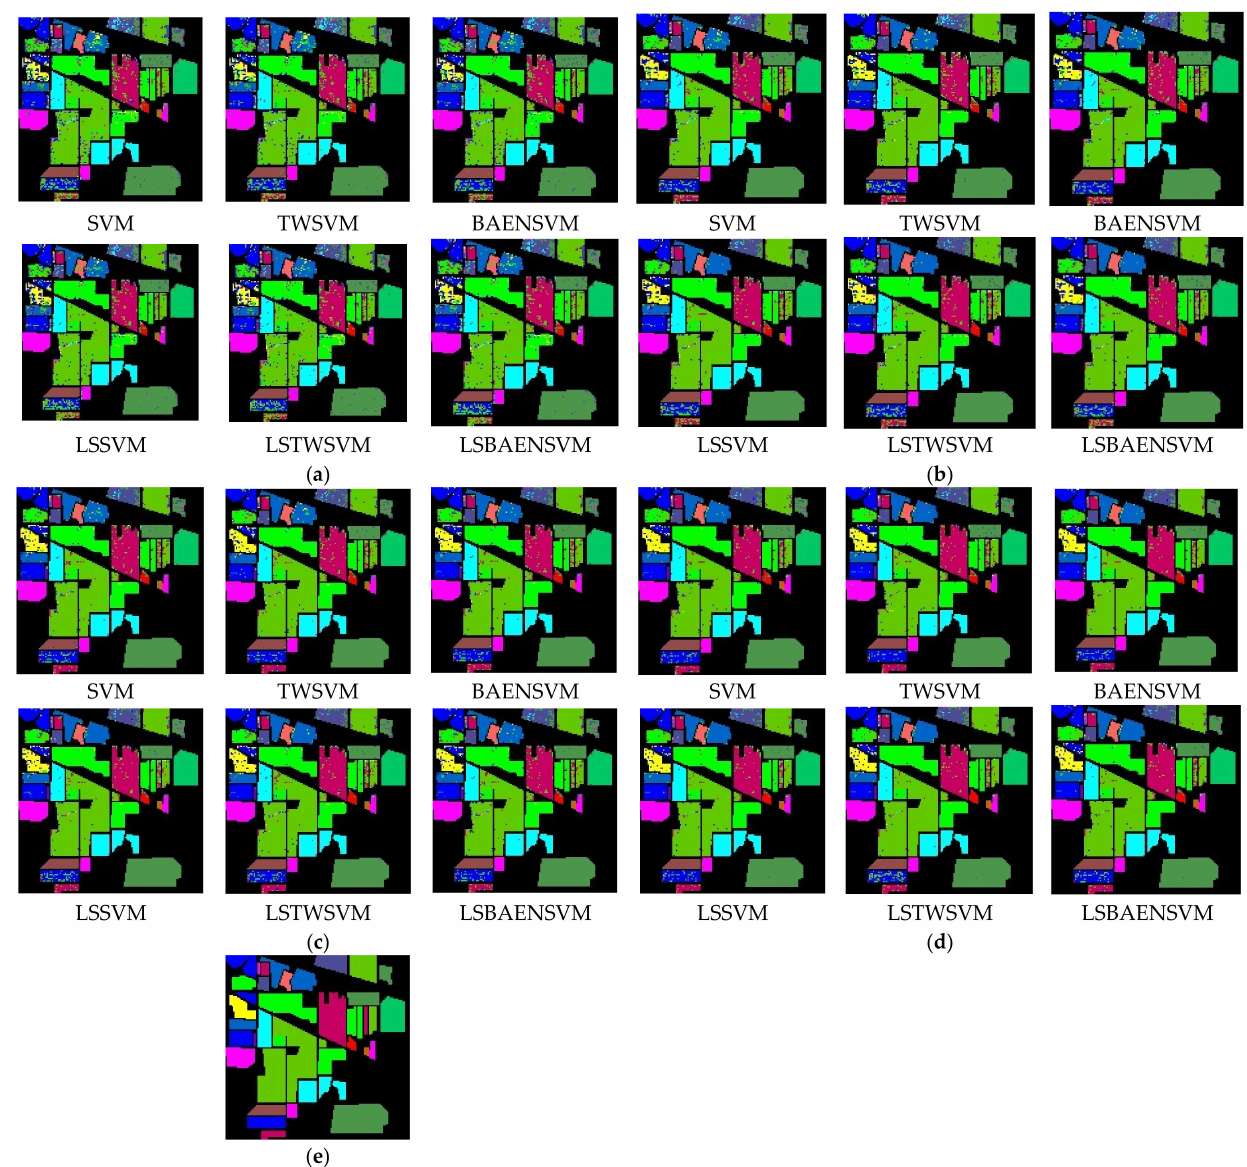
Figure 6. Indian Pines hyperspectral image classification result image. ( a ) 10% Indian Pines dataset, ( b ) 20% Indian Pines dataset, ( c ) 30% Indian Pines dataset, ( d ) 40% Indian Pines dataset, ( e ) ground